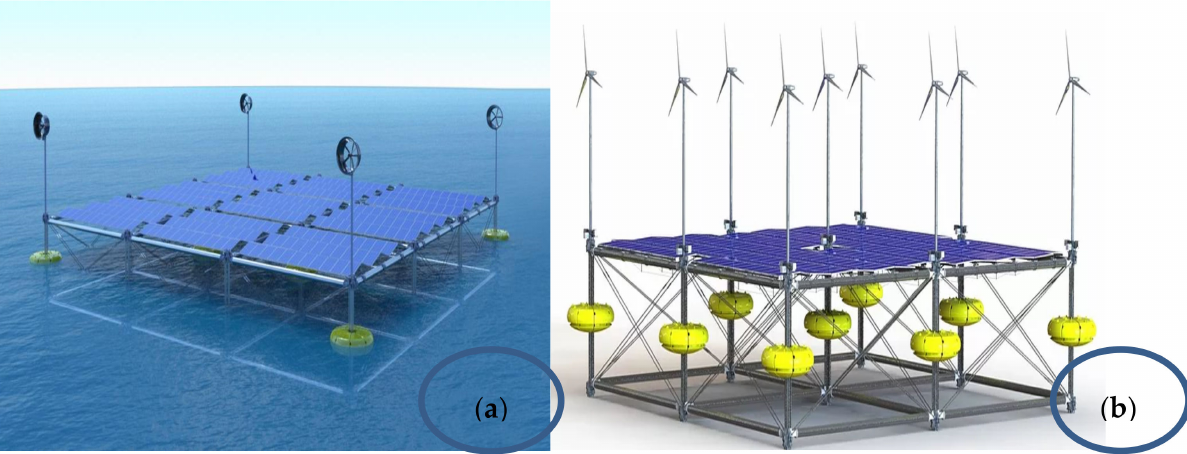
Figure 10. ( a ) Wave energy conversation (WEC) with floating solar ( b ) (WEC) with floating solar and wind (Source: Sinn